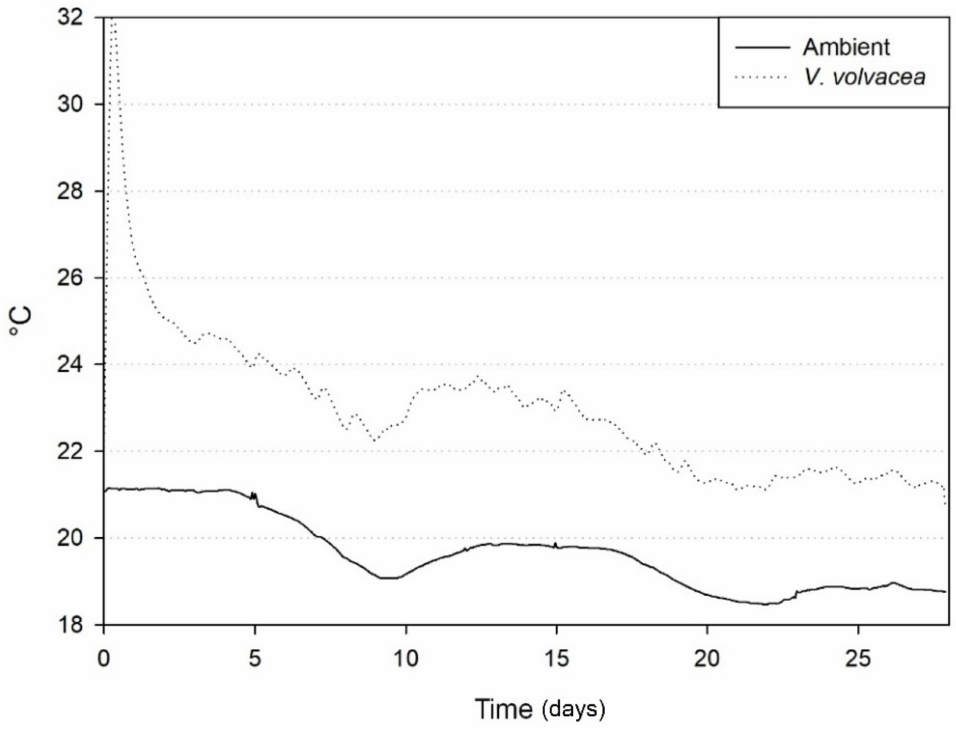
Figure 1. Temperature development in straw inoculated with V. volvacea for 28